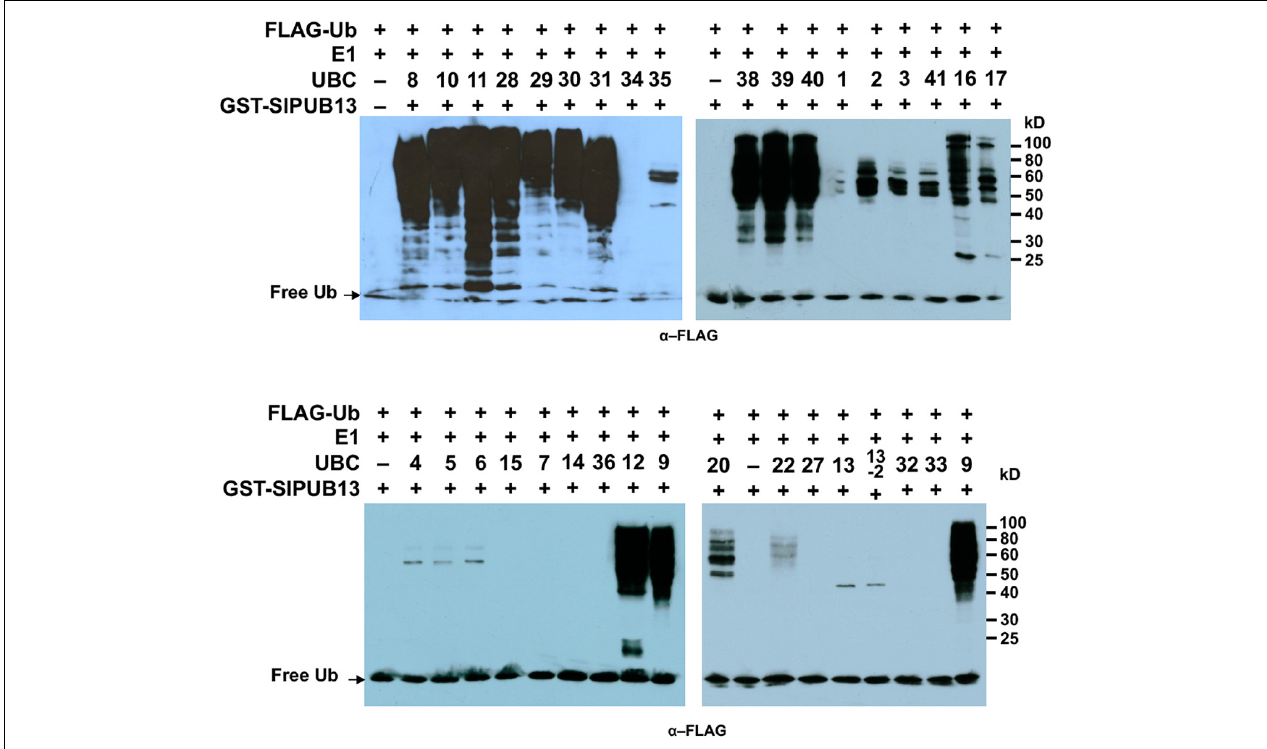
FIGURE 2 | SlPUB13 shows specificity toward group III E2s in in vitro ubiquitination assays. GST-SlPUB13 was tested against 34 purified tomato E2 proteins (Zhou et al., 2017) in in vitro ubiquitination assays to determine its specificity toward ubiquitin E2s. Tomato E2 protein used in each reaction is shown above the lane by their UBC number and the minus marker (–) denotes the absence of any E2 enzyme in the reaction. The presence of high molecular weight (MW) ( > 98 kD, size of GST-SlPUB13) smear of ubiquitinated proteins as detected by Western blot using anti-FLAG antibody indicates E2-E3 specificity. The numbers on the right denote the molecular mass of marker proteins in kilodaltons. This experiment was repeated two times with similar results.